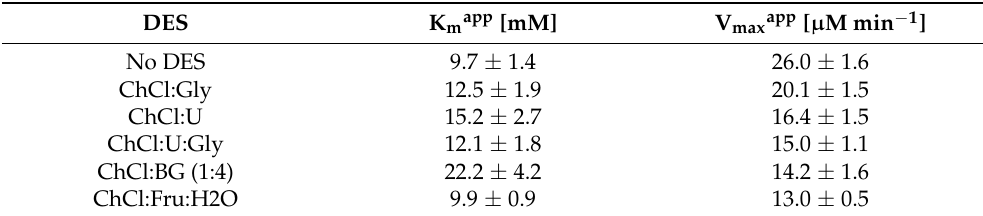
Table 2. Apparent kinetic parameters of tyrosinase mCLEAs for the oxidation of L-DOPA in 10% v / v aqueous solutions of DESs with the same HBD.